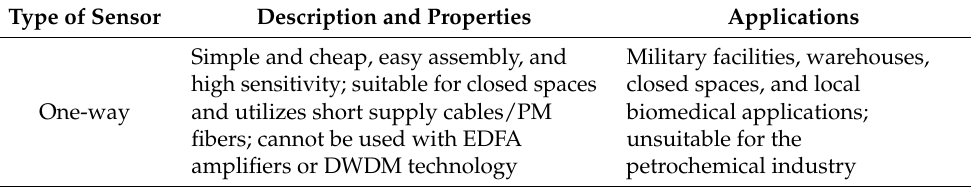
Table 1. Overview of the advantages and disadvantages of individual layouts and specific applications. Type of